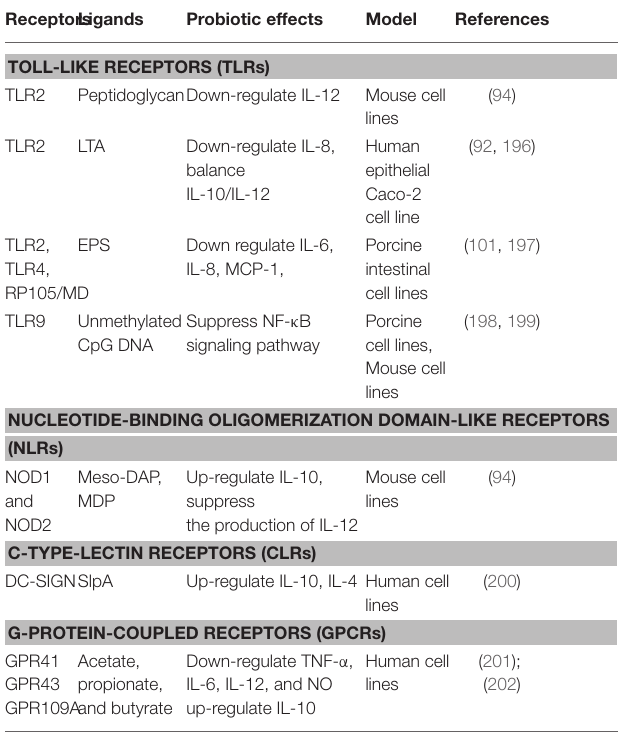
TABLE 2 | Receptors, ligands, and immunological